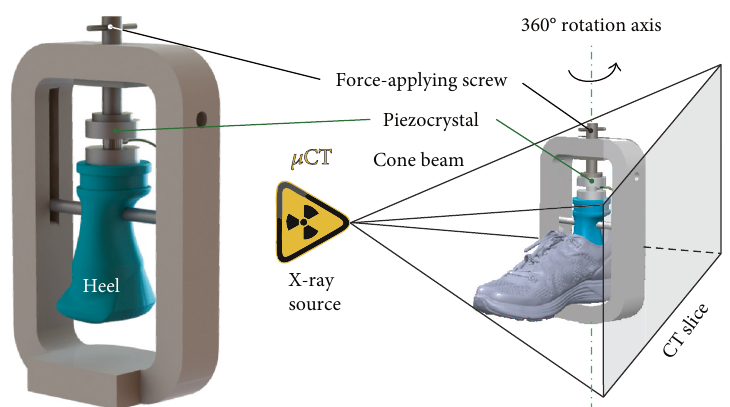
Figure 3: Experimental setup for the evaluation of structural support provided by the shoe.